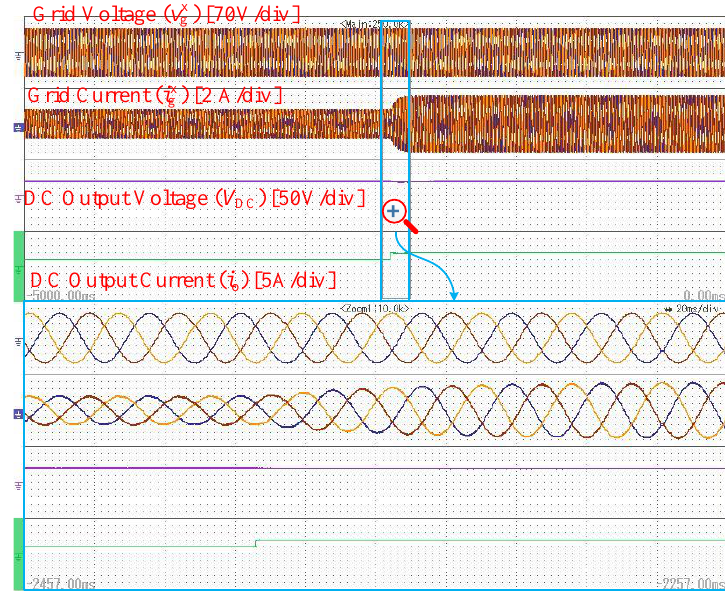
Figure 15. Experimental results during 50% load change.